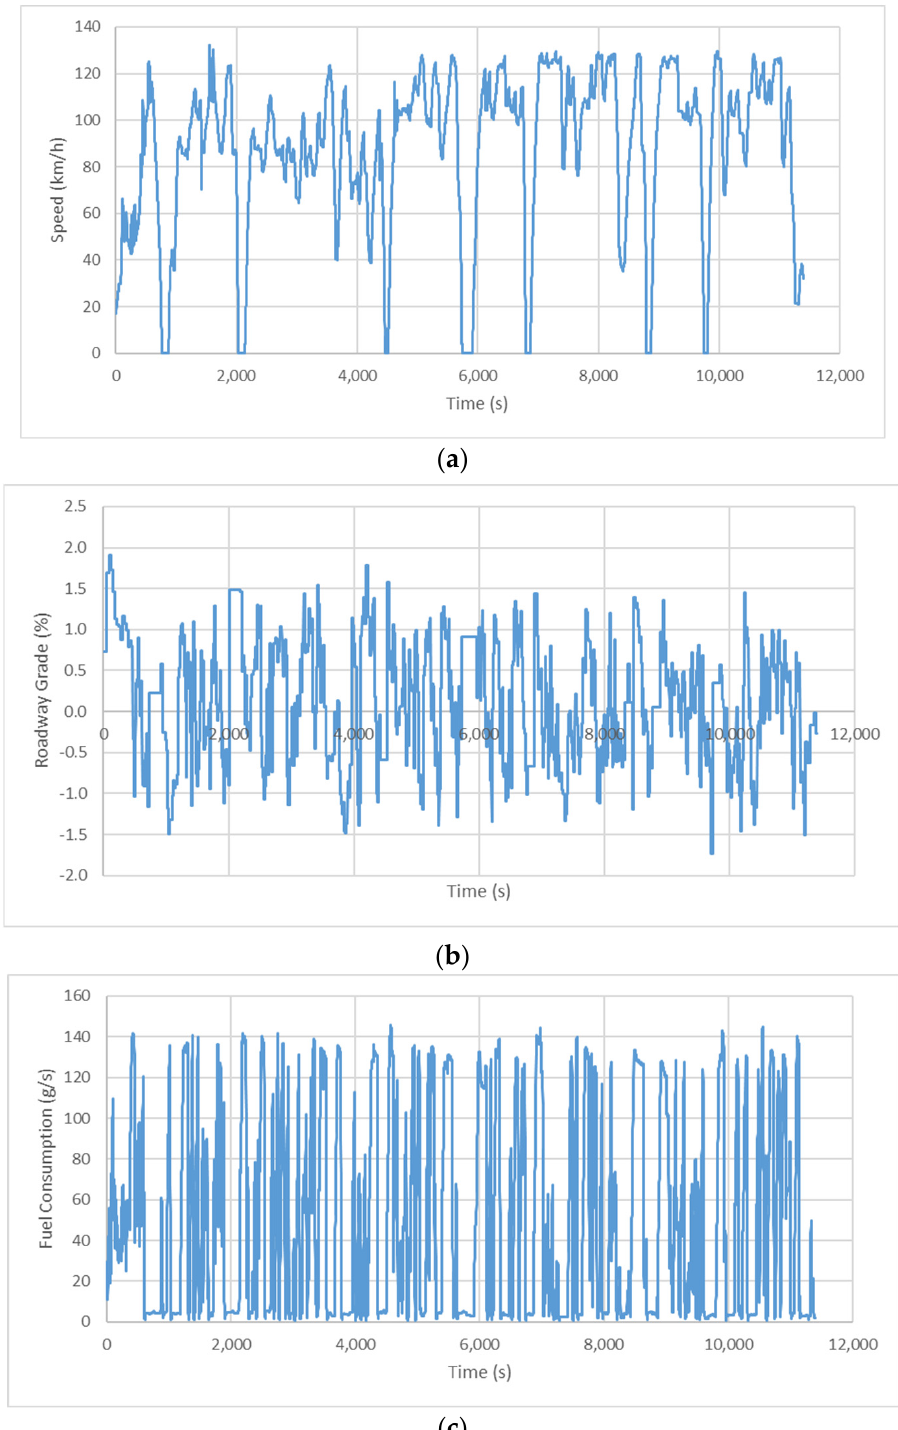
Figure 1. Sample trip—westbound: ( a ) speed; ( b ) grade; ( c ) fuel consumption.